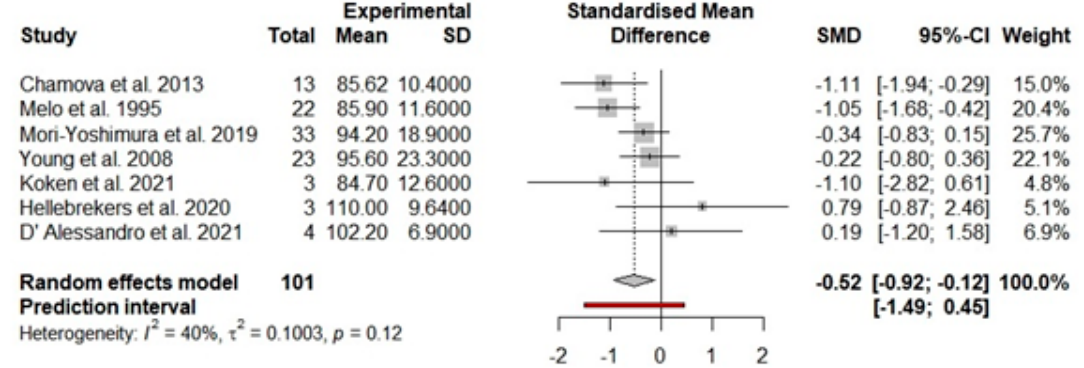
Figure 3. Forest plot of full-scale intelligence scores in the BMD population. Abbreviations used: CI = confidence interval; p = significance level; SMD = standard mean difference; SD = standard deviation